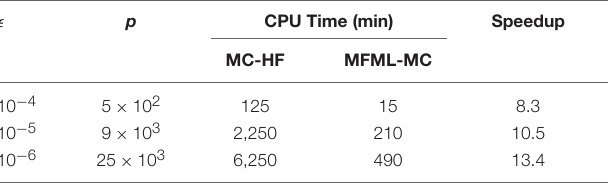
TABLE 1 | Performance chart of MFML-MC estimator for test case 1.